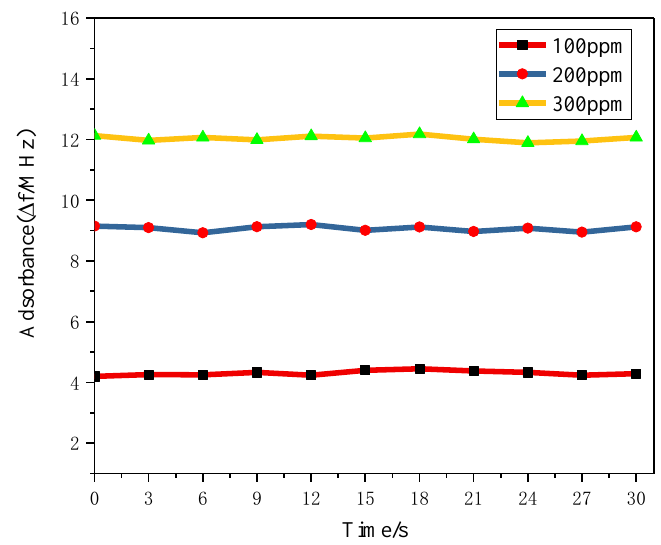
Figure 13. Sensor Stability: It can be seen that the sensor ’ s resonant frequency in long-term operation and the amount of change remain basically unchanged, indicating that the sensor has good stability.